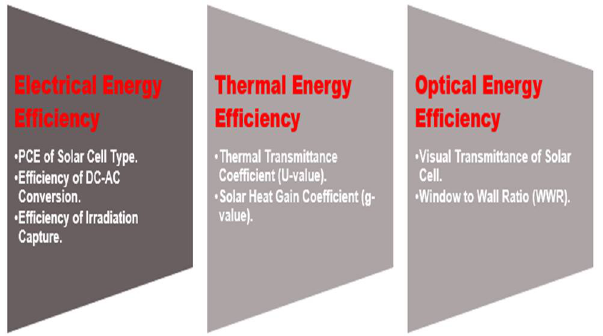
Figure 1. Framework for analysing the energy performance of semi-transparent BIPV.